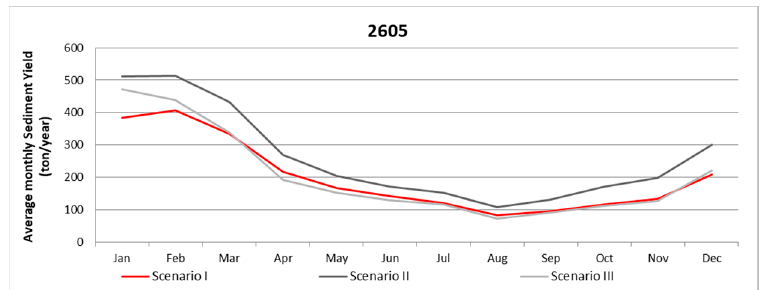
Figure 7. Average monthly sediment yield for 1990–2016 at monitoring station 2605 for each land use scenarios.